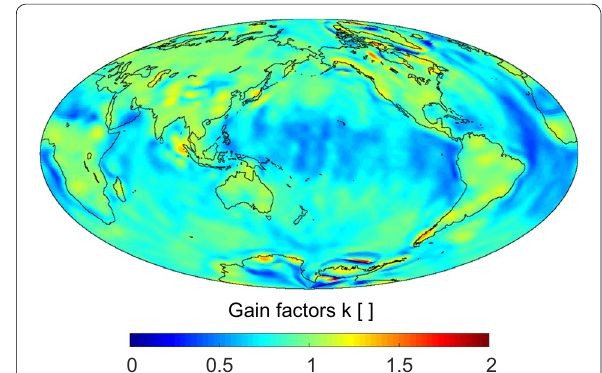
Fig. 6 Global grid point gain factors based on once- and